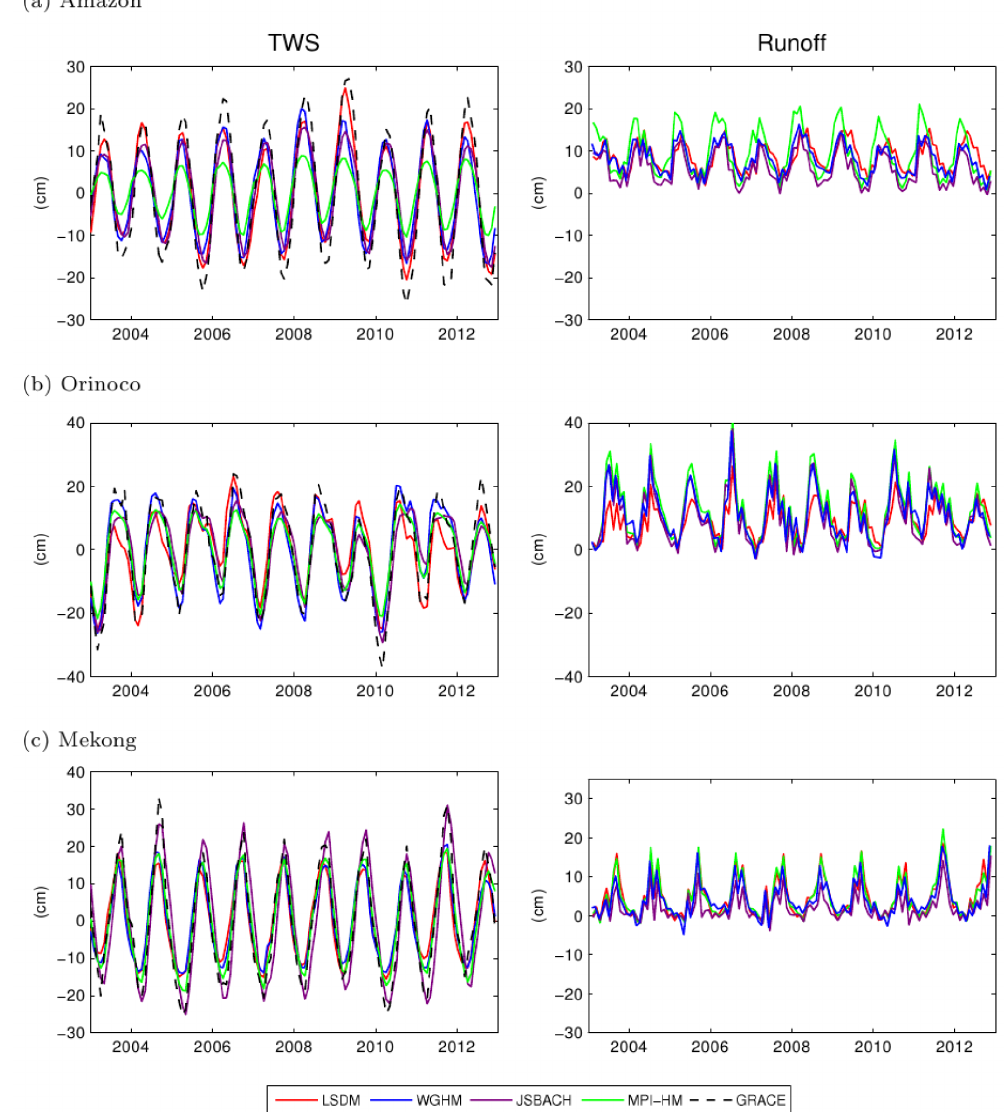
Figure 10. Time series of TWS (left) from GRACE and models and model-simulated runoff time series (right), each for three different catchments in the tropical zone: Amazon, Orinoco, and